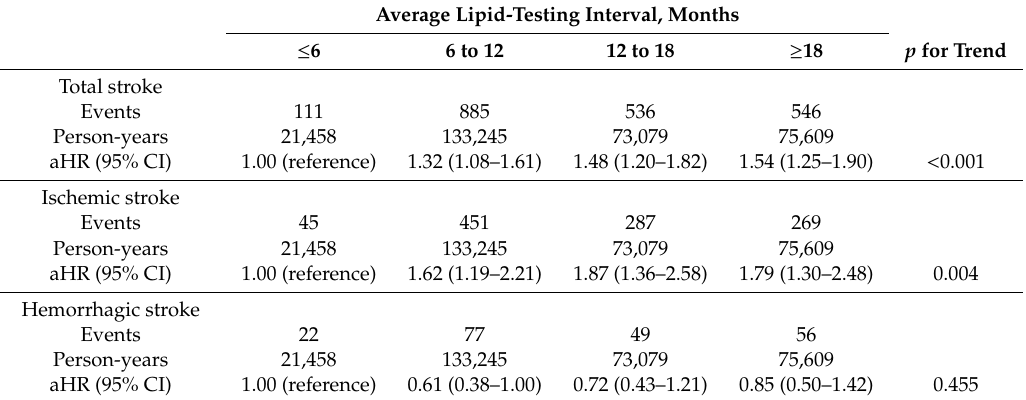
Table 2. Hazard ratios for stroke according to average lipid-testing interval among newly diagnosed dyslipidemia